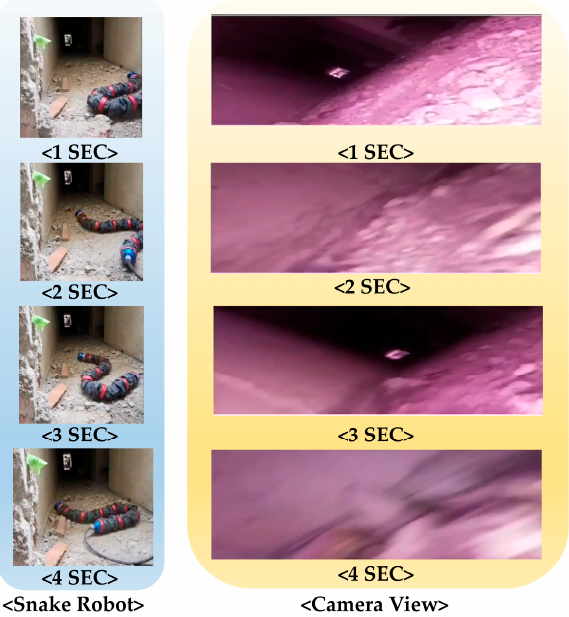
Figure 1. Image data when driving snake robot.